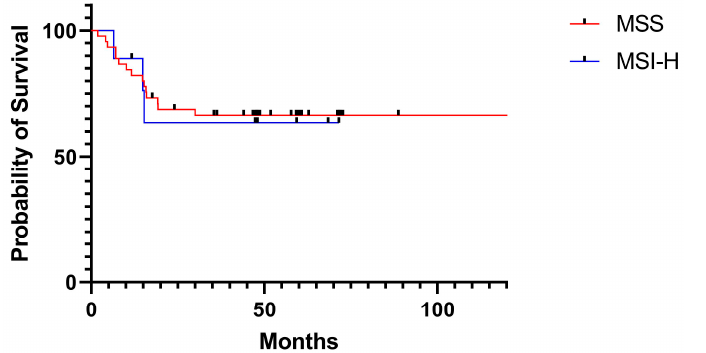
Figure 2. Kaplan– survival curves for patients with colorectal carcinoma by MSI status. MSI, microsatellite instability; MSI-H, high microsatellite instability; MSS, microsatellite stability. Table 2. PFS comparison between MSI-H and MSS patients.